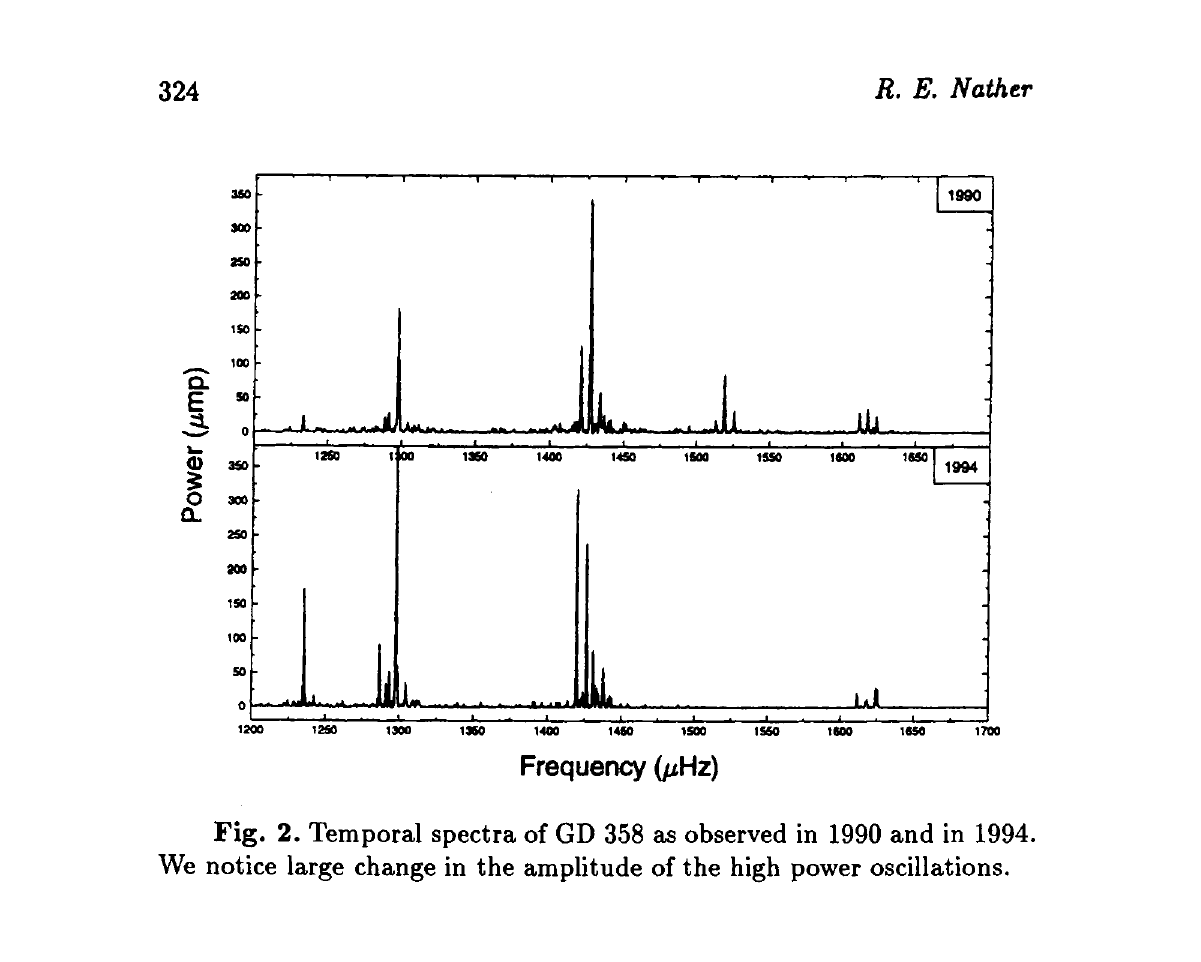
Fig. 2. Temporal spectra of GD 358 as observed in 1990 and in 1994. We notice large change in the amplitude of the high power